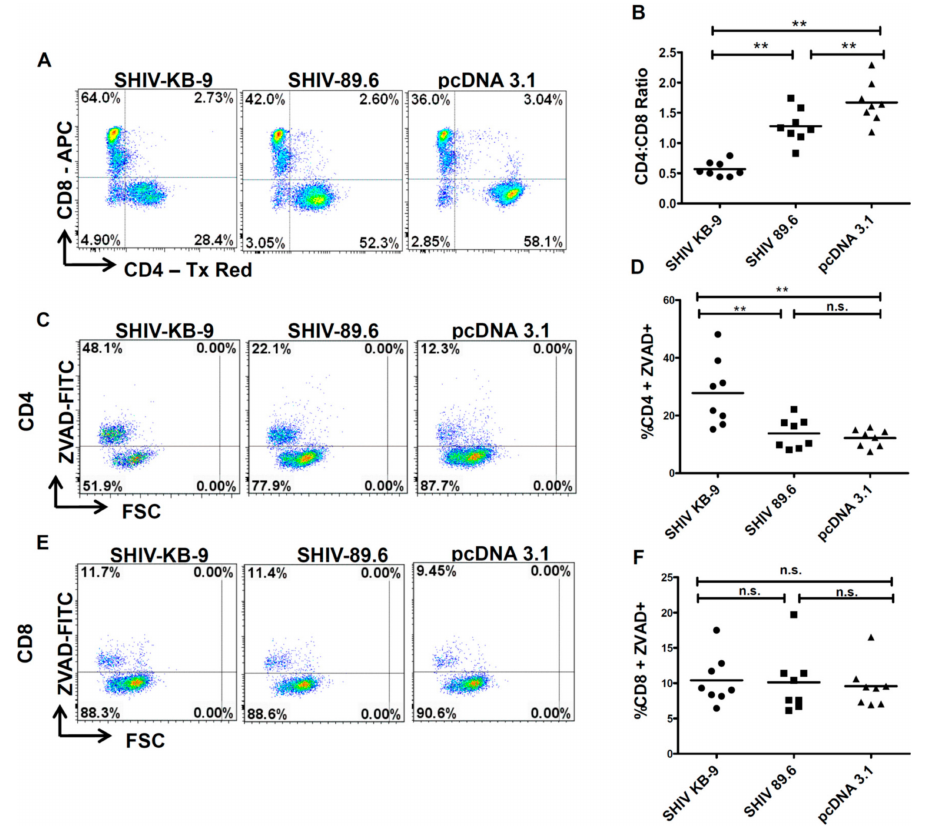
Figure 7. SHIV KB9 Env caused specific loss of CD4 cells via apoptosis in PBMC from healthy donors. HeLa cells were transfected with SHIV Envs (KB-9 and 89.6), or control vectors (pcDNA3.1) and co-cultured with PBMCs from healthy donors. At 48-hours post co-culture, PBMCs were collected and stained for CD3, CD4, CD8 and ZVAD-FITC and analyzed by flow cytometry. Cells gated on CD3 + population were analyzed for the CD4:CD8 ratio. Representative dot plots of the CD4:CD8 ratio are shown in ( A ) and results from eight di ff erent donors are shown in ( B ). Apoptosis was detected as ZVAD-FITC + cells in CD3 + CD4 + population. Representative dot plots of CD4 apoptosis are shown in ( C ) and results from 8 di ff erent donors are shown in ( D ). Apoptosis was detected as ZVAD – FITC + cells in CD3 + CD8 + population. Representative dot plots of CD8 apoptosis are shown in ( E ) and results from eight di ff erent donors are shown in ( F ). Wilcoxon matched-pairs signed rank test was used for statistical analysis (** = p ≤